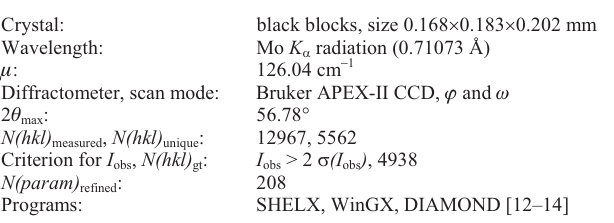
Table 1. Data collection and